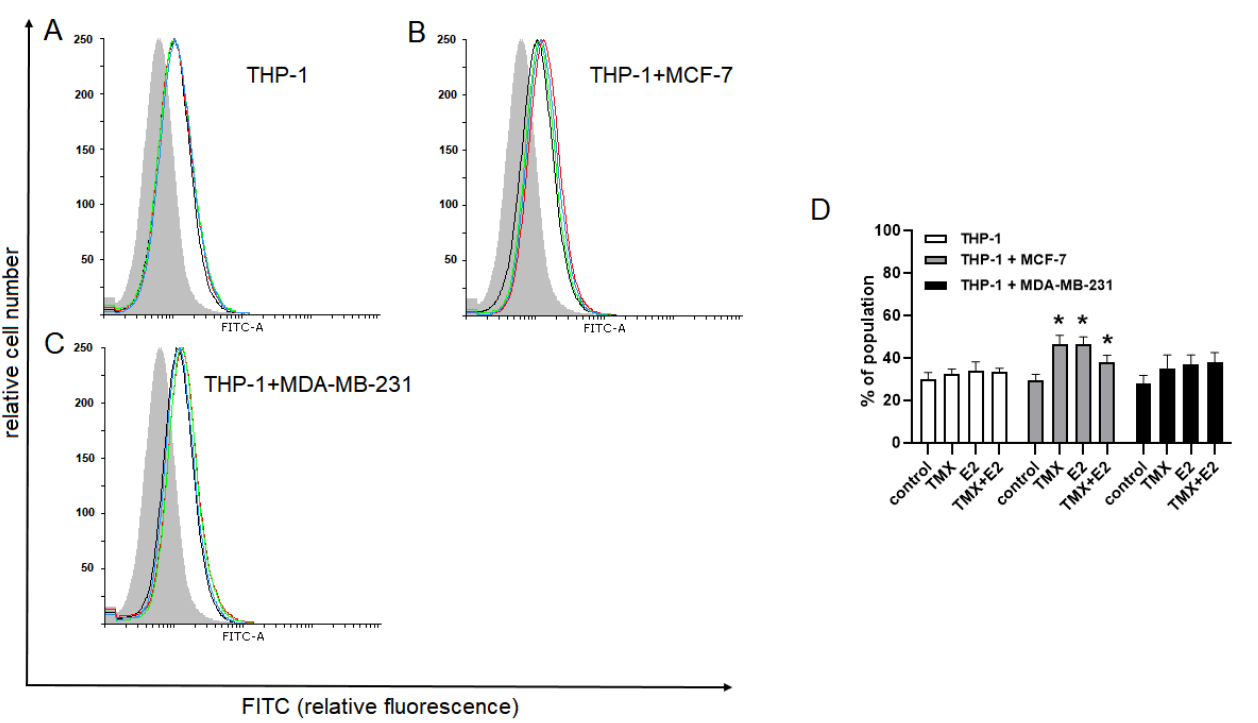
Figure 3. Expression of paired Siglec-5/Siglec-14 in human monocytic THP-1 cells grown in a monoculture ( A ) or the presence of MCF-7 ( B ) and MDA-MB-231 ( C ) cells in a co-culture transwell system and exposed to TMX and/or E2. Representative histograms ( A – C ) and corresponding bar graphs ( D ) were derived from flow cytometric analyses of 10,000 cells and show the isotype of the control (light grey histogram), the control cells (black line), TMX-treated cells (red line), E2-treated cells (green line) and cells concomitantly treated with TMX/E2 (blue line). Data are presented as the median percentage of each population (mean of 5 separate determinations). * p < 0.05 vs. the corresponding control group.